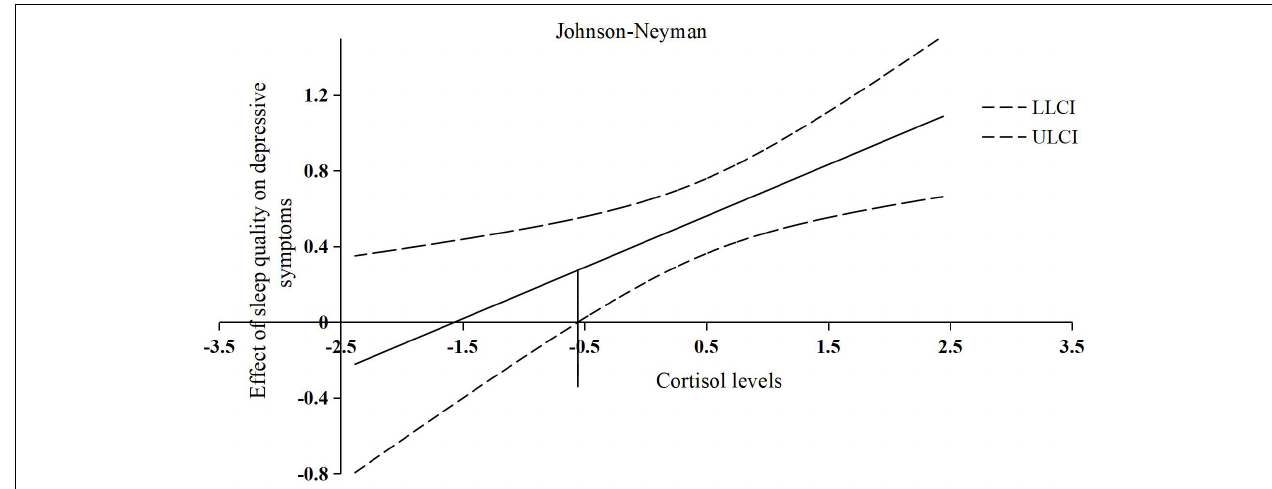
FIGURE 3 | The conditional effect of centered sleep quality on depressive symptoms across the range of centered and logarithmized cortisol levels. X -axis: represents the value of centered and logarithmized cortisol levels; Y -axis: represents the slope of the effect of centered sleep quality on depressive symptoms; the solid line in the center: represents the changing trend of the effect of centered sleep quality on depressive symptoms with the change of the value of centered and logarithmized cortisol levels; the horizontal line at − 0.55: represents a threshold of centered and logarithmized cortisol levels; LLCI, lower 95% CI; ULCI, upper 95%